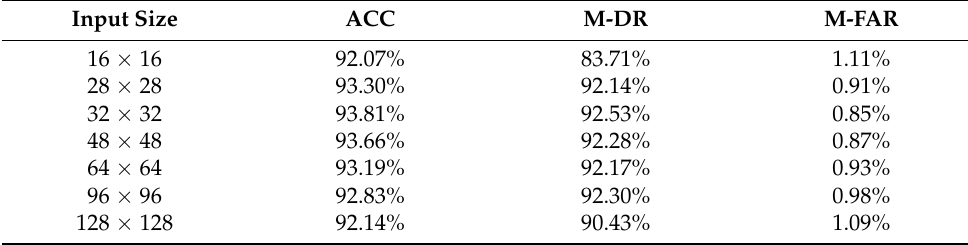
Table 7. Results of nine-class classification with different input sizes.